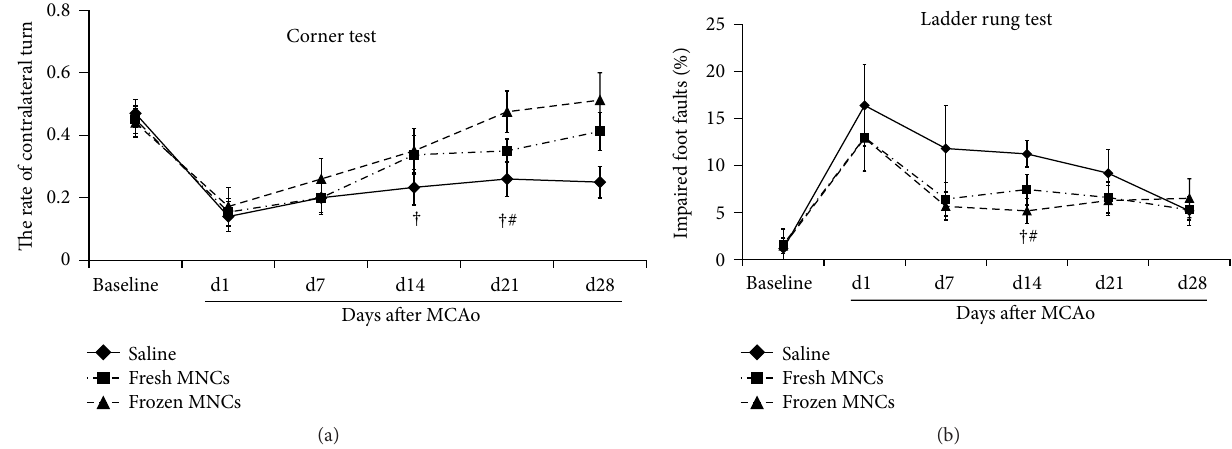
Figure 2: Line diagrams illustrating the neurofunctional improvement in mice treated with MNCs IV at 24 hours after stroke. Animals were assigned to 3 treatment groups: saline ( 𝑛 = 10 ), fresh MNCs ( 𝑛 = 8 ), or frozen MNCs ( 𝑛 = 8 ). All animals were evaluated on the corner test (a), where smaller value in 𝑦 -axis meant more severe deficits and ladder rung tests (b), where larger value in axis meant more severe deficits, up to 28 days after stroke. Data are mean ± SD; † : 𝑝 < 0.05 , frozen MNCs versus saline; #: 𝑝 < 0.05 , fresh MNCs versus saline.